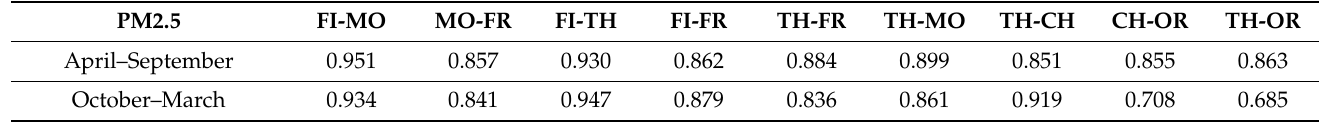
Table 7. Lin’s coefficient for PM2.5, calculated for some pairs of stations, for both semesters. PM2.5 FI-MO MO-FR FI-TH FI-FR TH-FR TH-MO TH-CH CH-OR